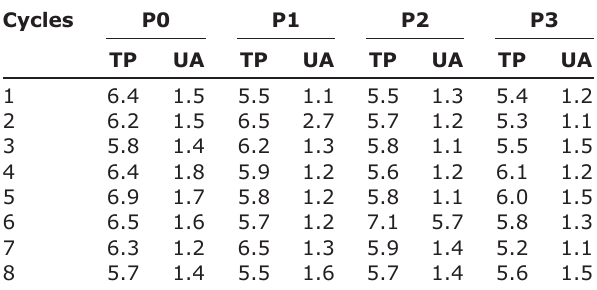
Table-2: Results of the white rat blood serum examination in the form of TP and UA. Cycles P0 P1 P2